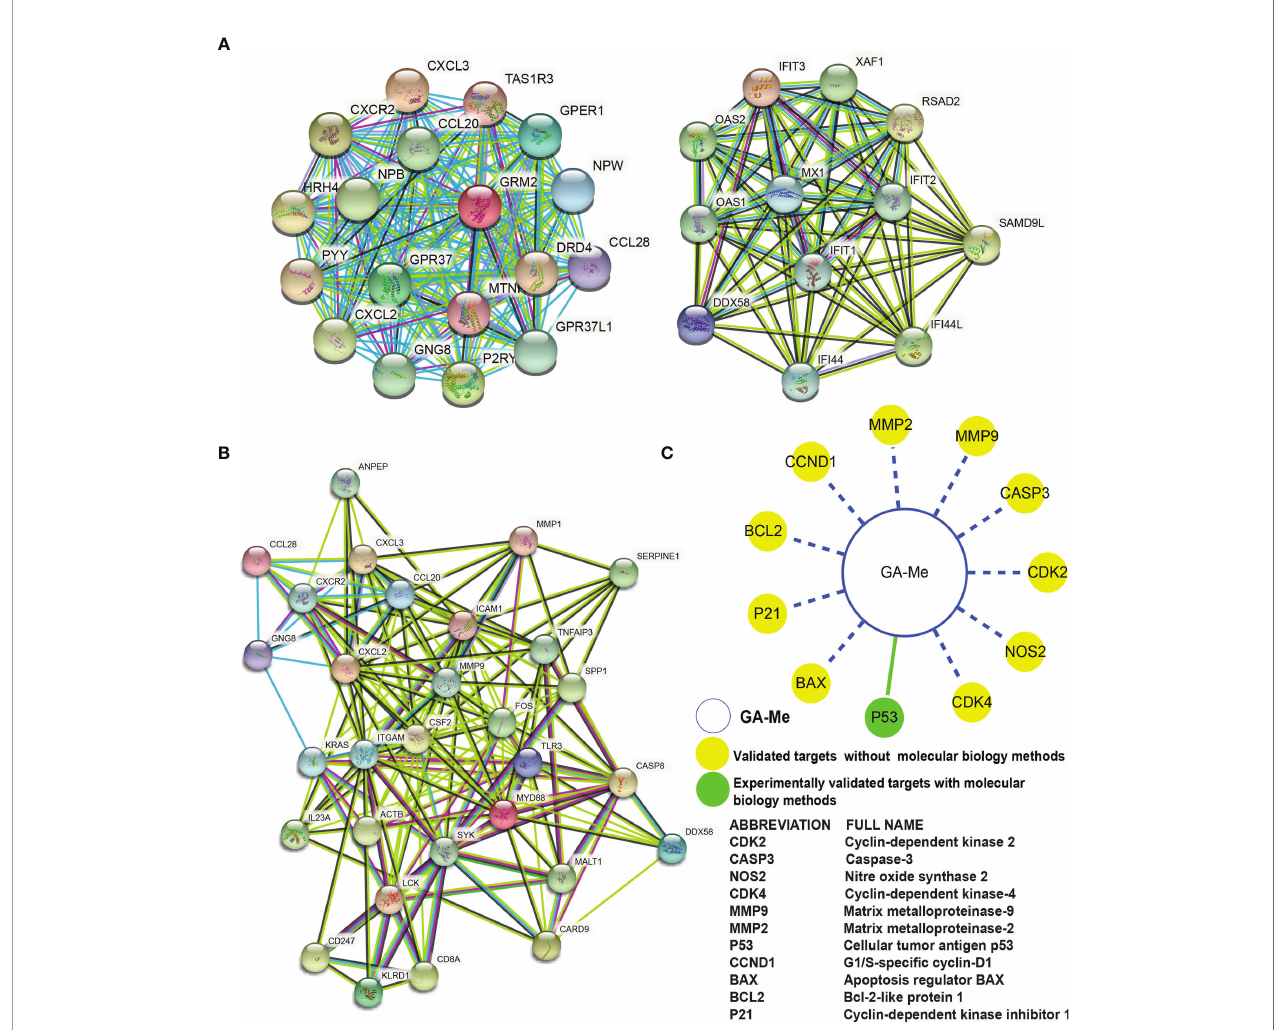
FIGURE 8 | PPI network analysis of DEGs in GA-Me-treated and untreated HCT116 cells. (A) The PPI network showed the top 30 hub DEGs among the total DEGs and their interactions with each other. (B) The PPI network showed the top 30 hub DEGs among 94 immune-related DEGs and their interactions with each other. The darker the color, the more critical the effect. Line colors indicate the type of interaction evidence (red: predicted interaction based on gene fusion; yellow: text mining; green: predicted interaction based on gene neighborhood; blue: predicted interaction based on gene cooccurrence; light blue: known interaction from a curated database; purple: known interaction experimentally determined; black: coexpression; lilac: protein homology). (C) Systems pharmacological analysis of GA- Me. The green solid line indicates experimentally veri fi ed ligand-target interactions. The blue dashed line indicates predicted ligand-target